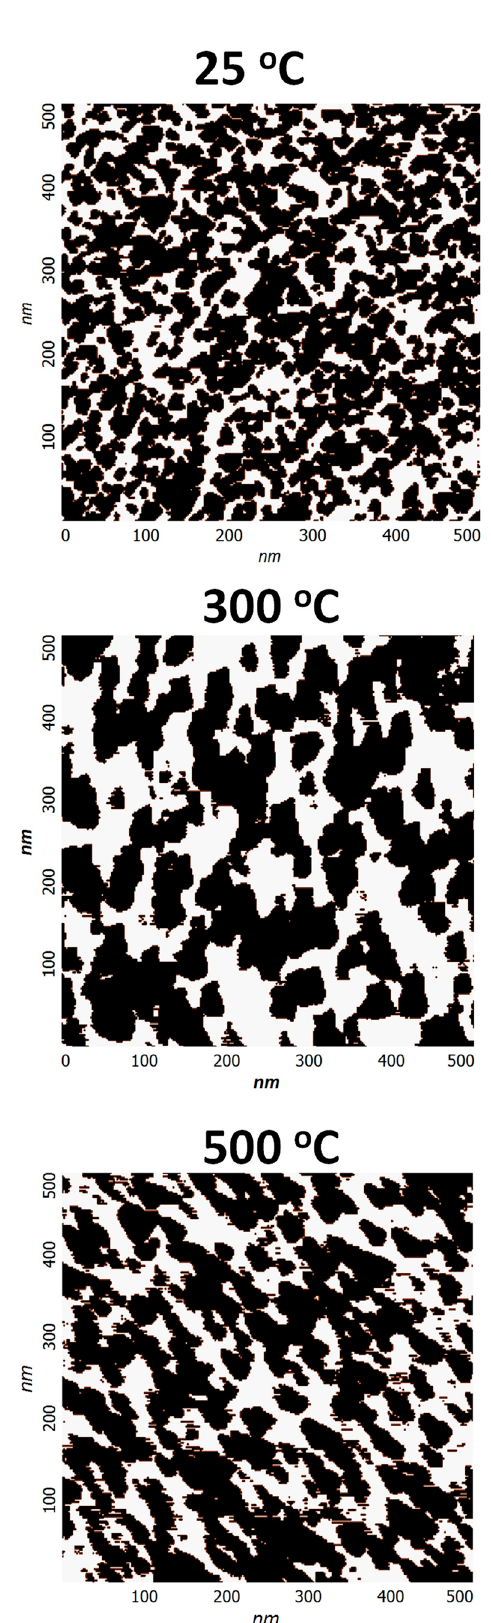
Figure 5. Grain analysis for Mo films deposited at different temperatures. As indicated in the images, as the temperature increases, the grain size increases gradually while intra-grain voids become less and less visible.